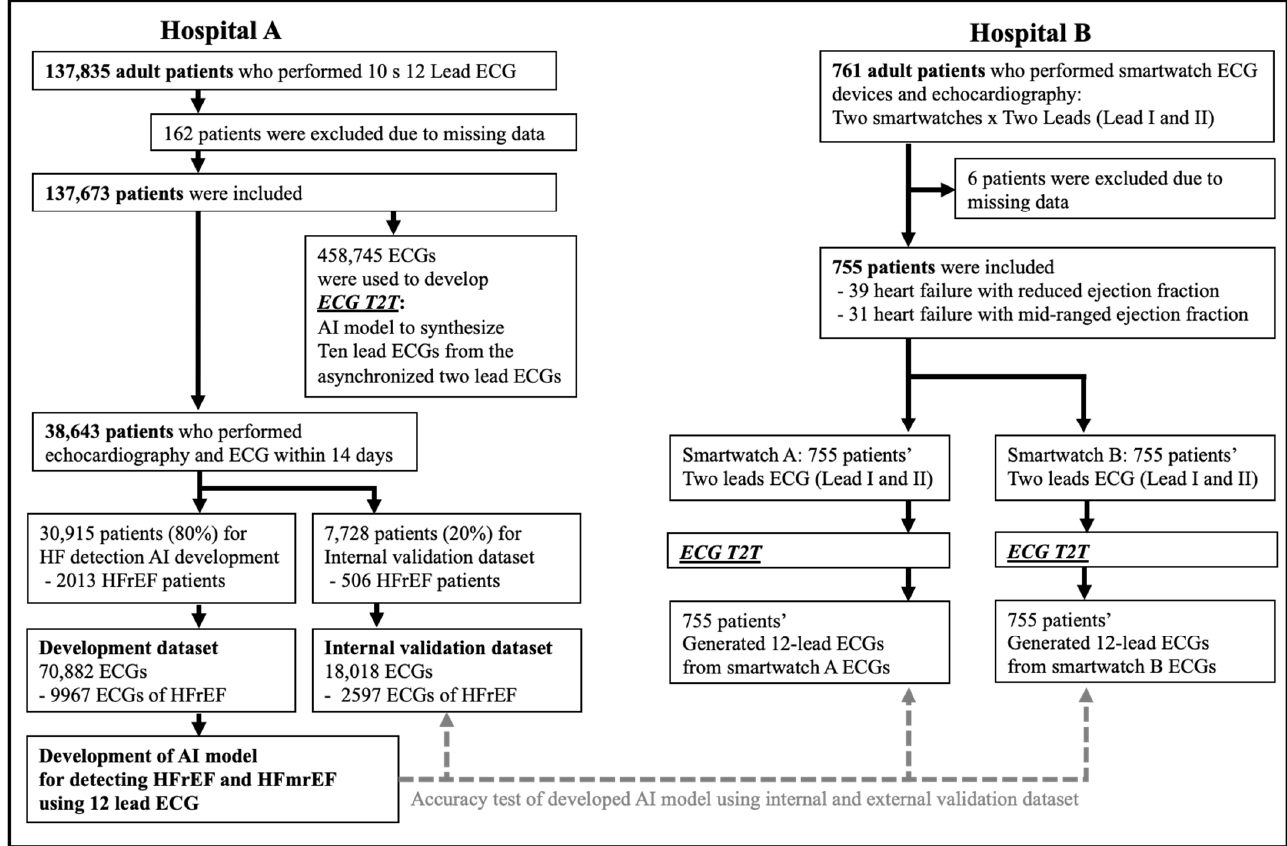
Figure 1. Study flowchart. Legend: AI denotes artificial intelligence, ECG electrocardiography, ECGT2T ECG synthesis from two-lead to ten-lead, HF heart failure, HFmrEF heart failure with mildly reduced ejection fraction, and HFrEF heart failure with reduced ejection fraction.